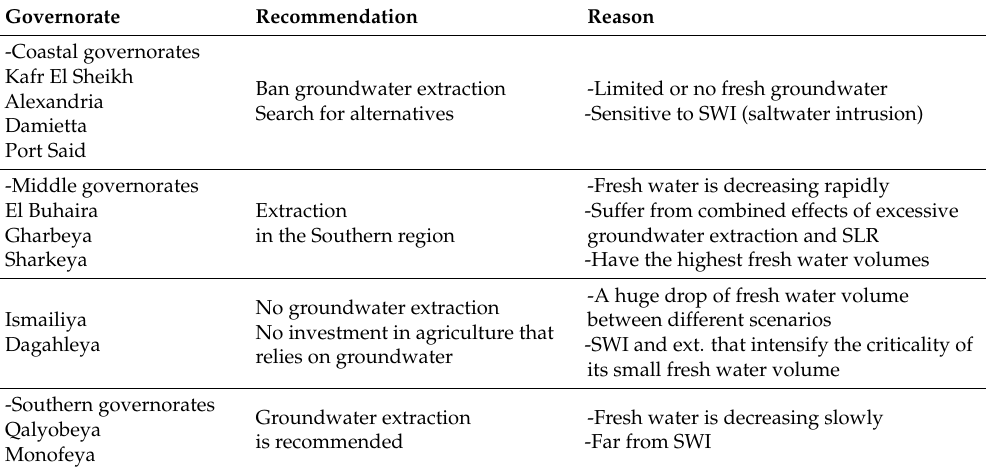
Table 4. A summary of the recommended groundwater extraction locations in the Nile Delta